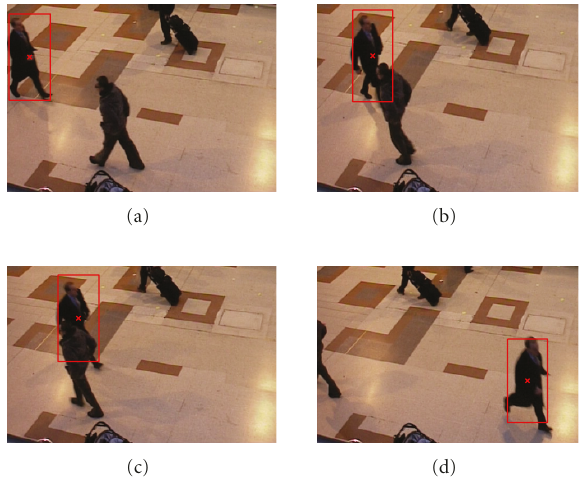
Figure 17: (a) Reference frame (Frame #102), (b) Frame #110, (c) Frame #113, and (d) Frame